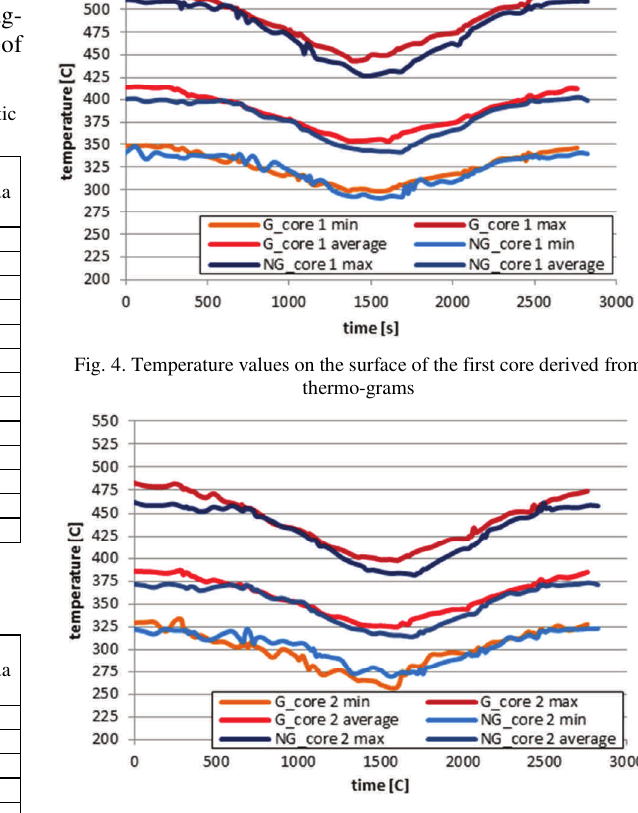
Fig. 5. Temperature values on the surface of the second core derived from